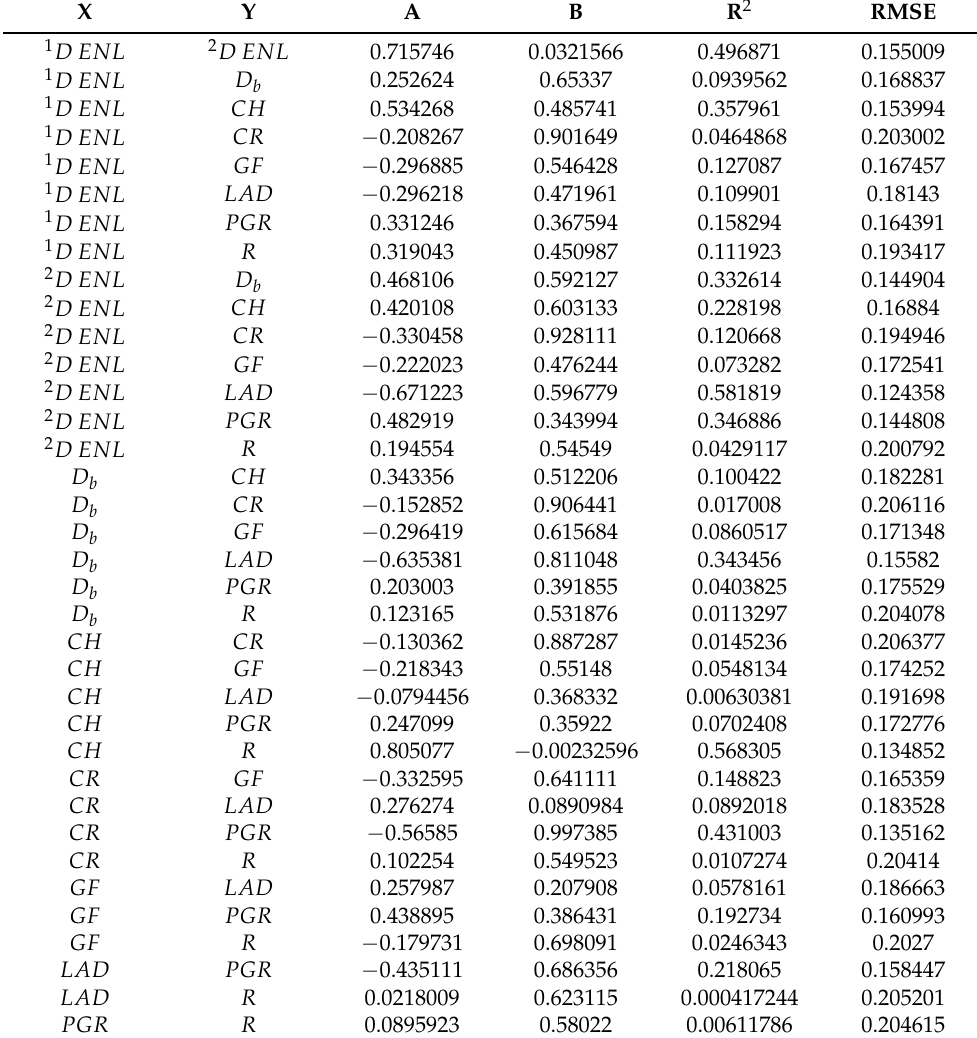
Table A18. Overview of TLS linear regression at 5m grid